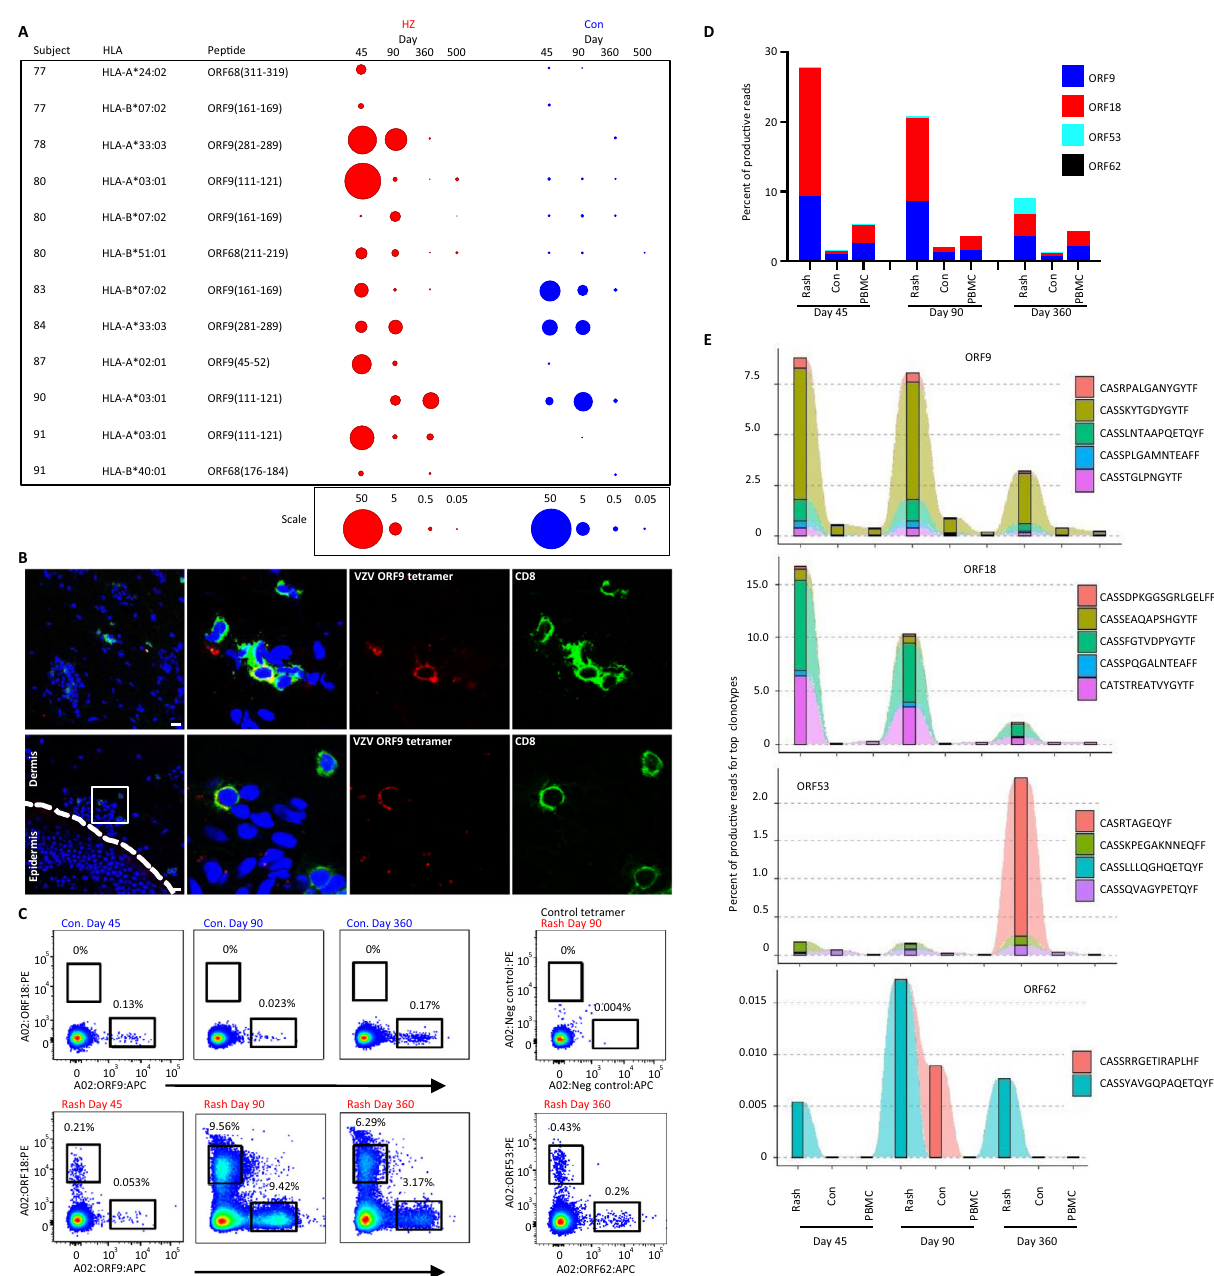
Fig.5|VZV-speci fi cCD8Tcellclonotypespersistlong-terminpost-zosterskin. A BubbleplotsofthepercentageofCD8Tcellsinskin-TCLreactivetotheindicated peptideepitopes show VZV-speci fi c CD8 T cellpersistencewell afterherpes zoster resolution. Frequencies represent net IFN γ + events amongst all live CD3+ lym- phocytes calculated by subtracting IFN γ + events in DMSO-exposed controls. Bub- bles sizes are scaled as indicated at bottom. B In situ staining of post-HZ skin biopsies con fi rm the presence of HLA-A*03:01-ORF9-tetramer (peptide AVYENPLSVEK) positive CD8 T cells in the dermis. Top images are for subject 91, day 45 (VZV DNA positive) HZ biopsy; bottom images are for subject 90, day 90 (VZV DNA negative) HZ biopsy. C HLA-A*02:01 tetramers speci fi c for distinct VZV epitopes were used to isolate VZV-speci fi c CD8 T cells from the T cell lines of subject 79 for TRB sequencing after DNA isolation. D Skin biopsy and